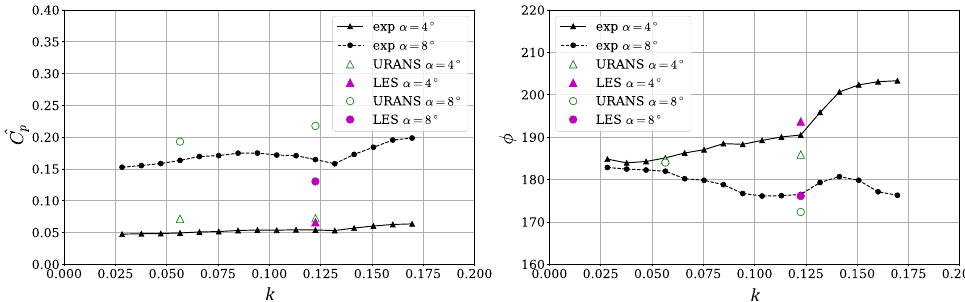
Figure 13. Variation of unsteady pressure amplitude and phase with reduced